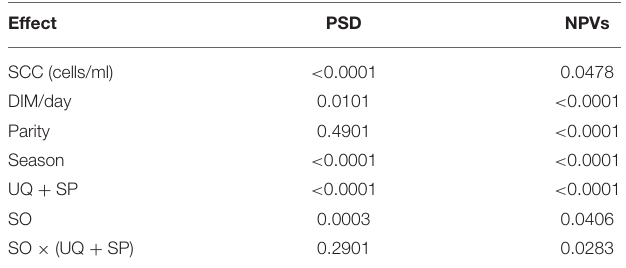
TABLE 2 | The least square means of NPVs and PSD by SCC, DIM, season, UQ + SP, and SO categories for buffaloes (Mean ±